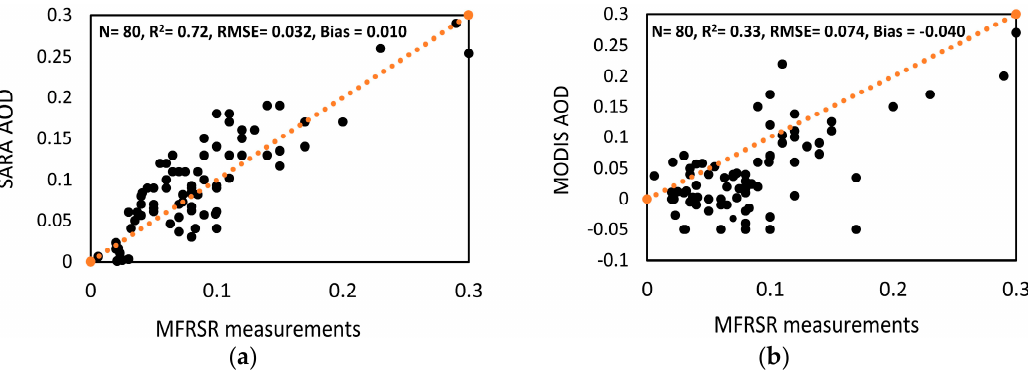
Figure 3. Scatterplots of SARA 1-km AOD ( a ) and MODIS 3-km AOD ( b ), respectively, and the Multi-filter Rotating Shadowband Radiometer (MFRSR) AOD at the ARM SGP sites.